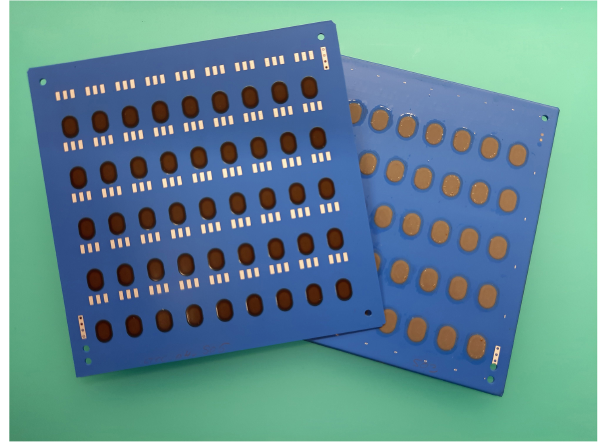
Figure 7. LTCC multilayer with 45 pH sensors. Top: pH electrode; bottom: reference electrode.